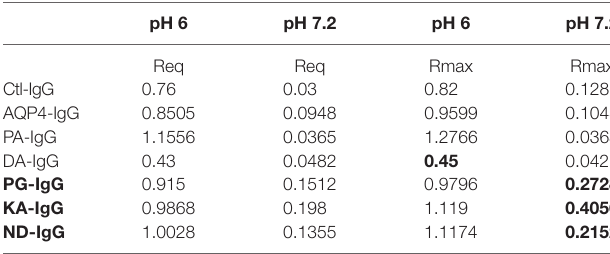
TaBle 2 | Binding of antibodies to mouse FcRn.